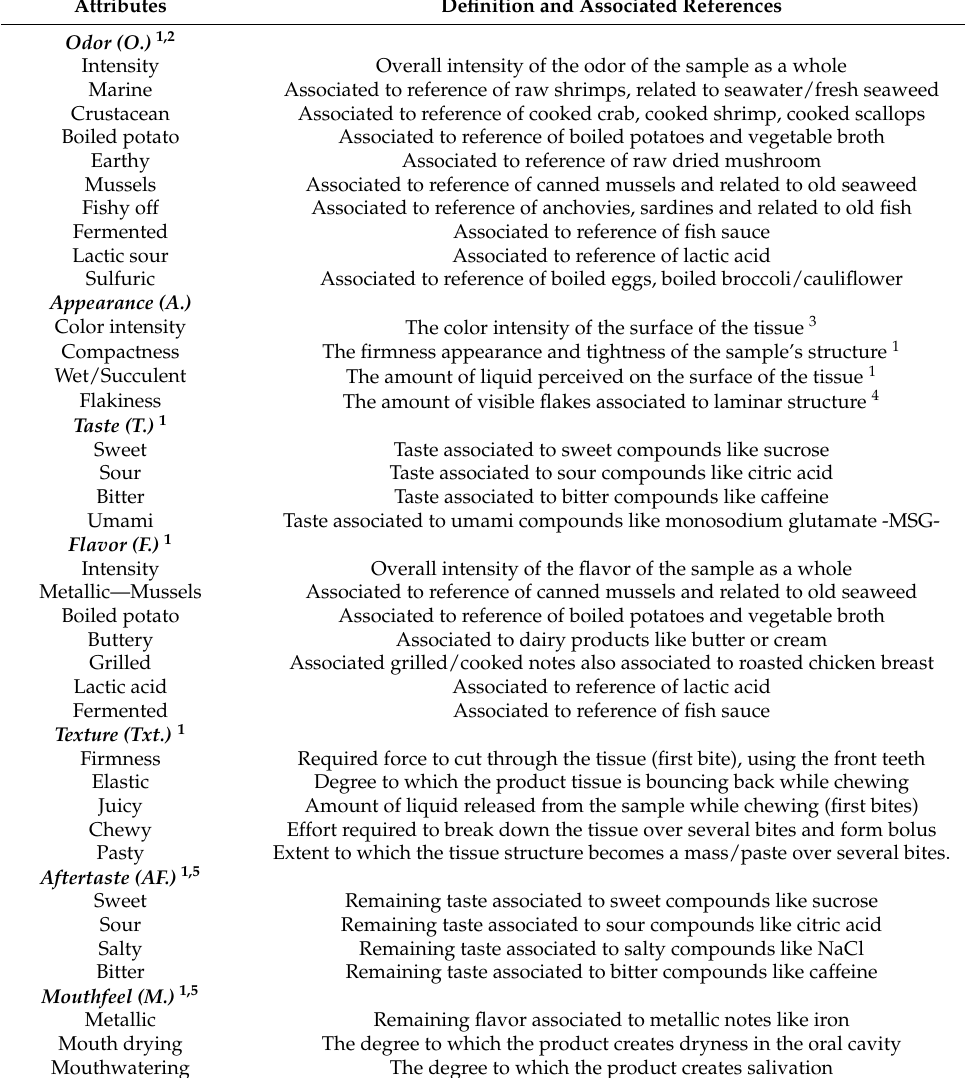
Table 2. Sensory attributes used in the final Descriptive Analyses (DA) evaluation, divided in modalities, along with their definitions and associated references used during the training